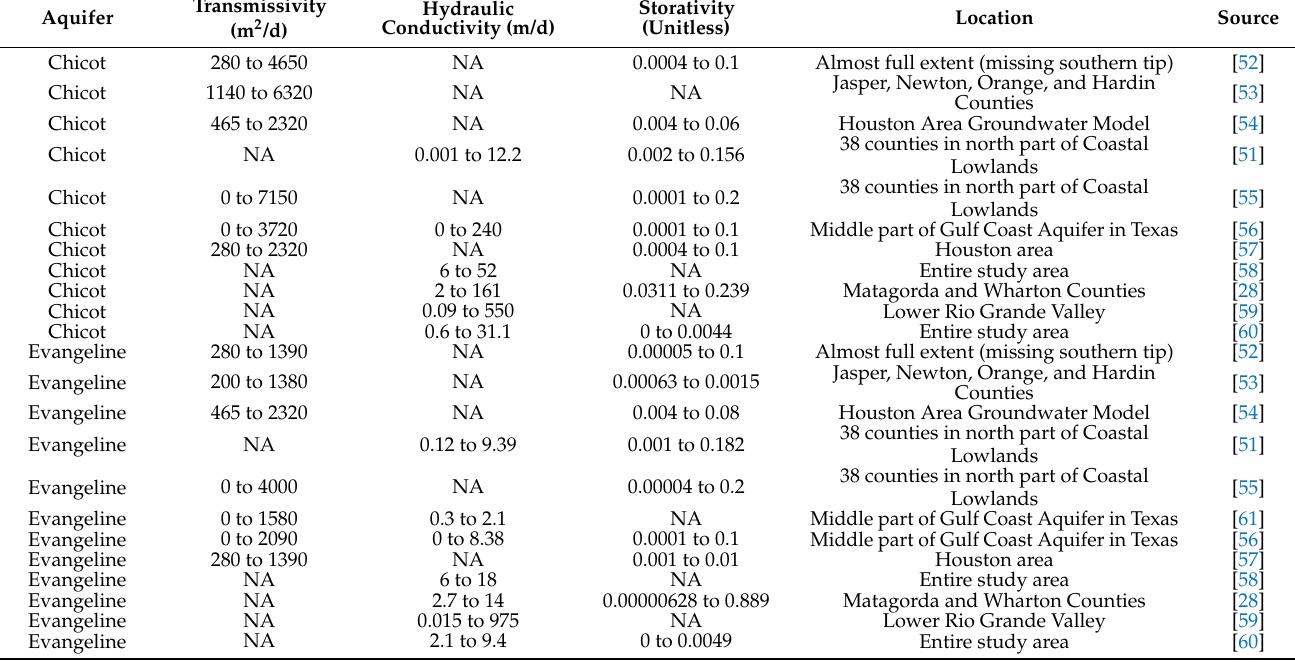
Table 1. Historical transmissivity, hydraulic conductivity, and storativity values within